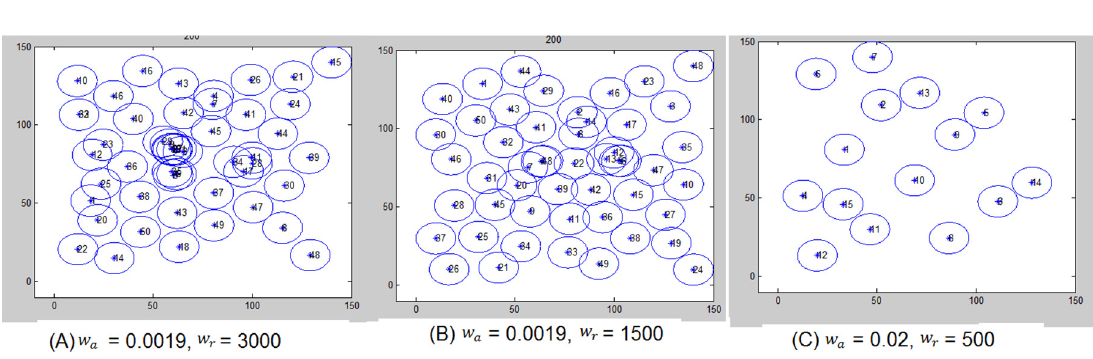
Figure 4. The effect of different settings of w r , N =50, and N =15.